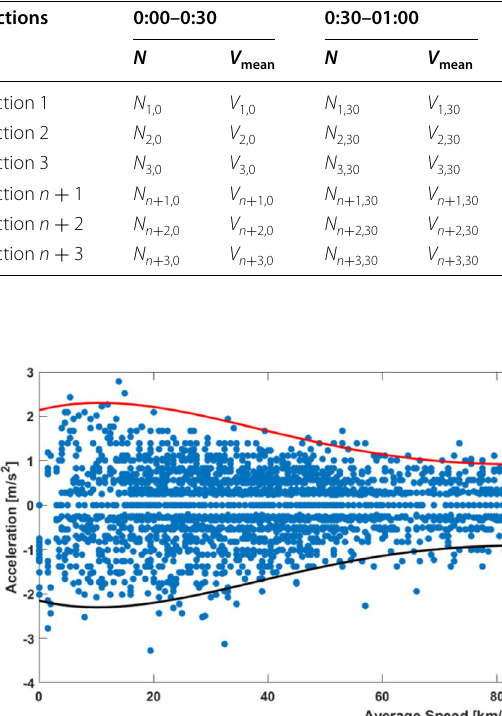
Table 1 An example of half-hour-based traffic activity data Sections